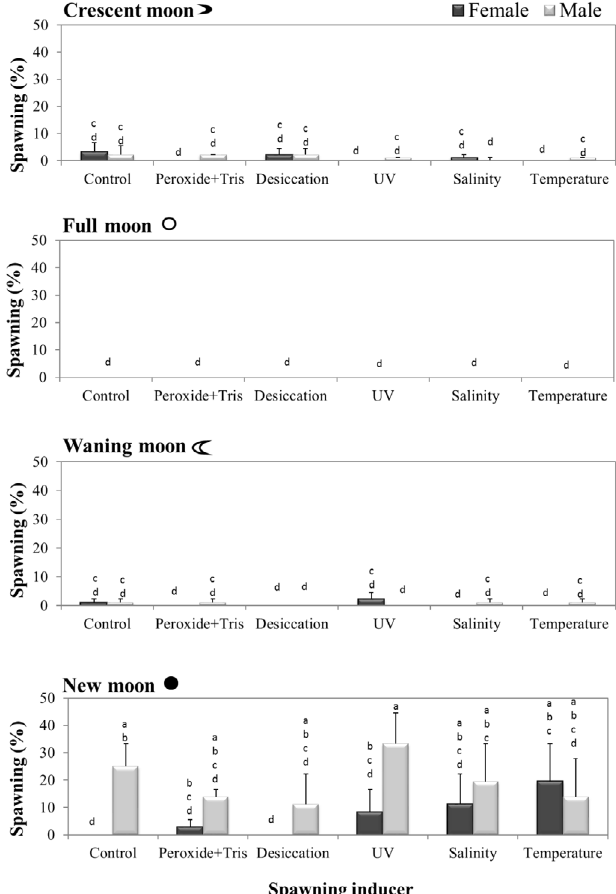
Fig. 2. Cittarium pica . Percentage of spawning individuals (male and female) in response to the application of different stimuli and moon phases. Values are means±S.E. n > 12. Spawning inducers with the same case letters belong to a homogeneous group identi fi ed by the Bonferroni multiple range test. Signi fi cant differences existed among the groups ( p < 0.05).